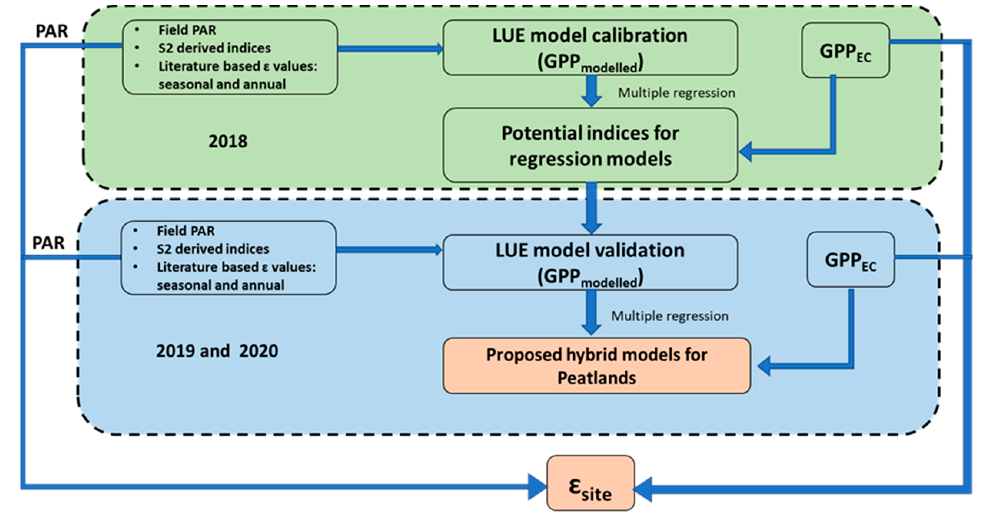
Figure 2. The modelling framework showing calibration and validation steps to derive hybrid models and to derive site-specific LUE parameters. Light orange boxes show objectives of this study; blue and green boxes show time frame for calibration and validation.